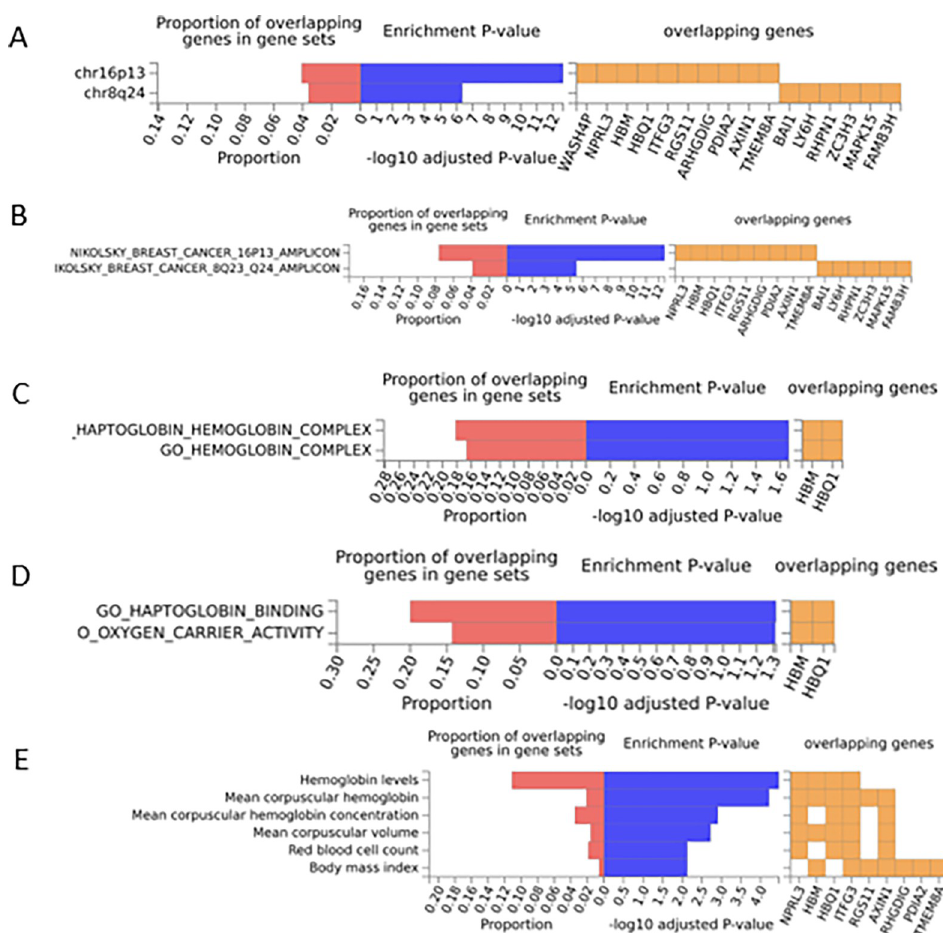
Fig 2. Enrichment of input genes in gene sets for the UGR cohort (A) Positional gene sets (MsigDB c1) (B) Curated gene sets, (C) GO cellular components (MsigDB c5), (D) GO molecular functions (MsigDB c5), (E) GWAS catalog reported